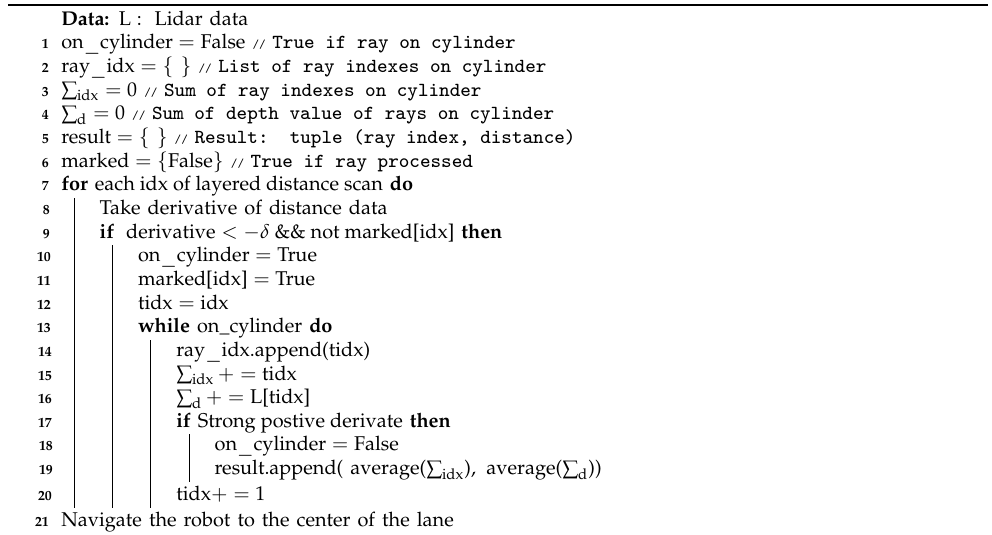
Algorithm 1: Safe Navigation with Feature (Pillar) Detection from